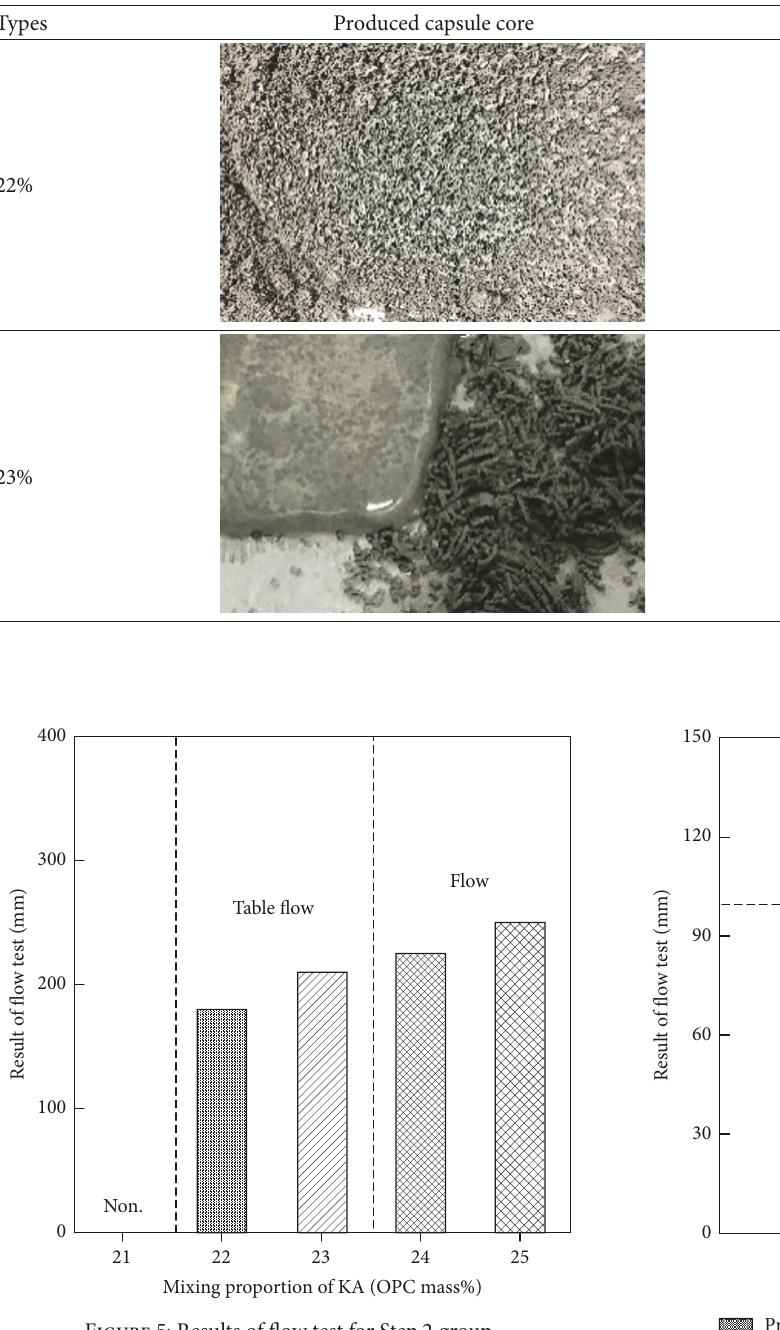
Table 4: Form of produced capsule cores.